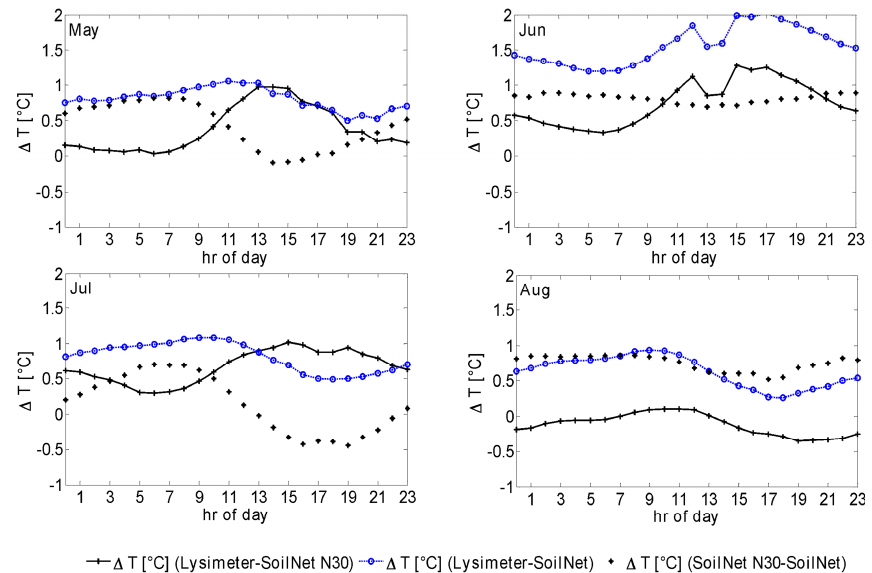
Figure 13. Differences in daily mean soil temperature (averaged over the six lysimeters), a nearby SoilNet device (SN30), and the mean of all available SoilNet devices located at the study